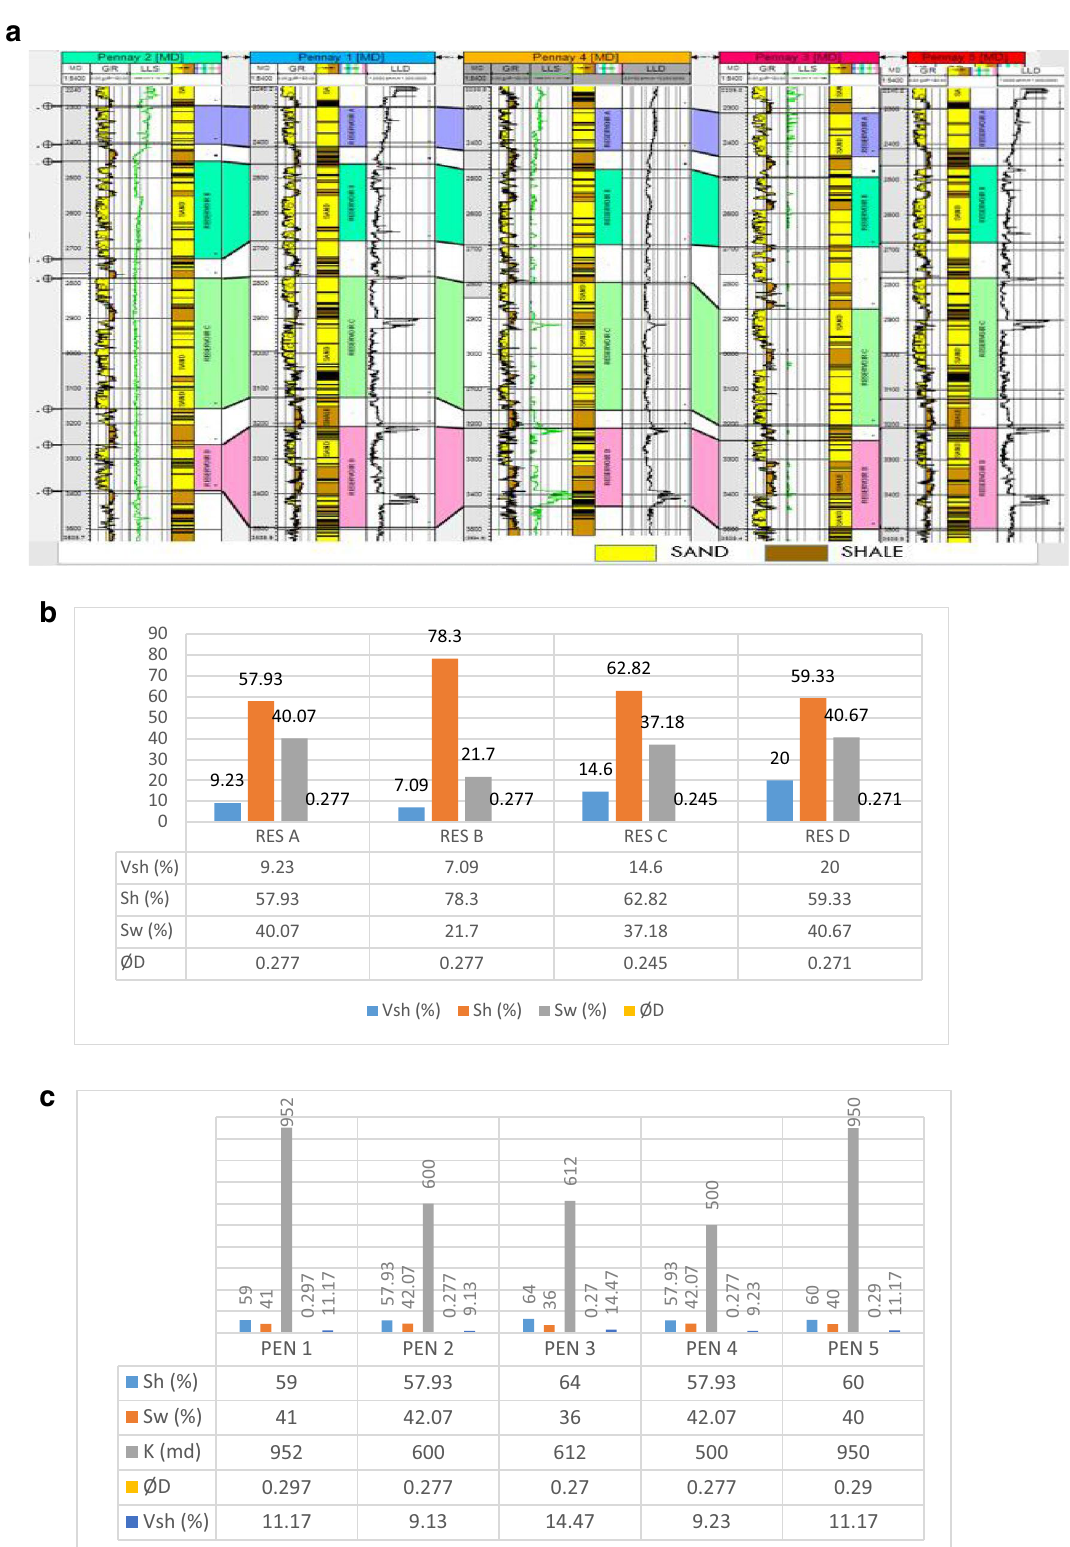
Fig. 11 a Lithostratigraphic correlation section across the reservoirs. b Comparison of bar chart of hydrocarbon saturation, water satura- tion, porosity, and volume of shale across reservoirs. c Comparison